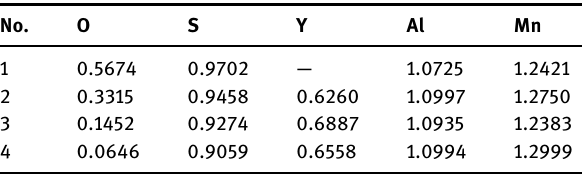
Table 4: The activity coefficients of O, S, Y, Al, and Mn in liquid steel